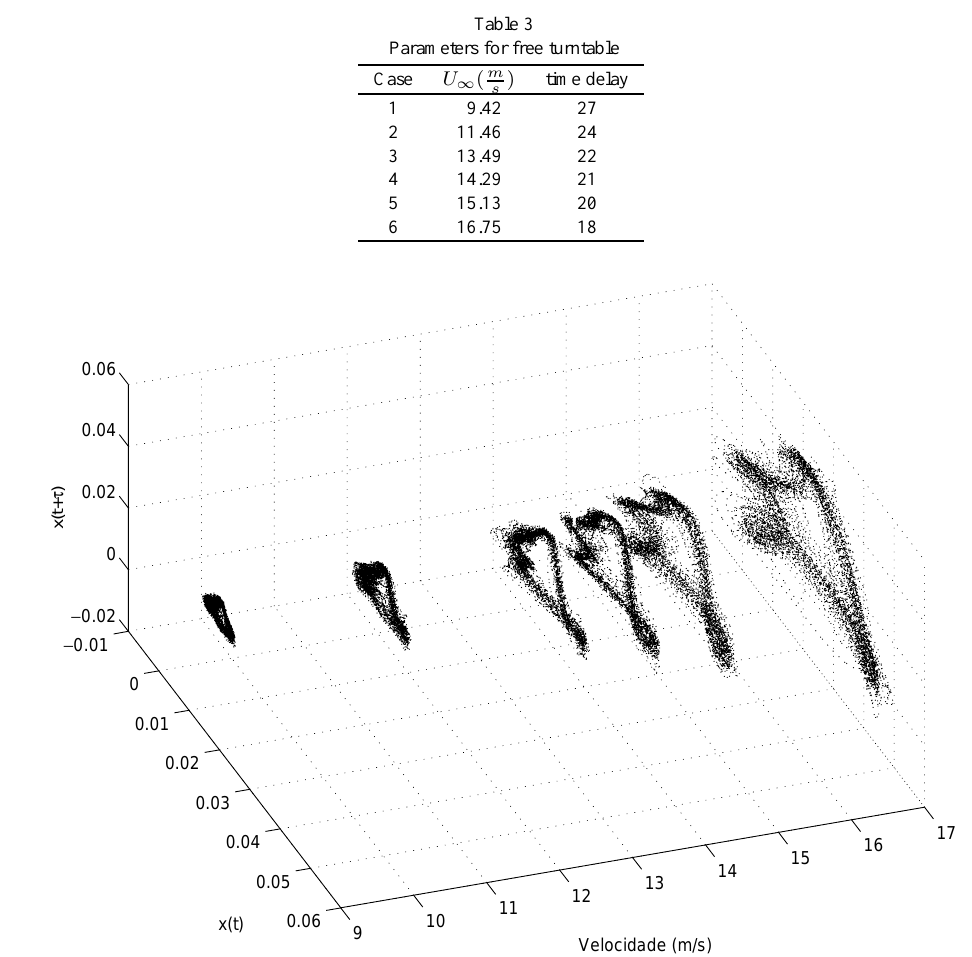
Fig. 9. Evolution with respect to the freestream velocity of reconstructed state spaces for free turntable